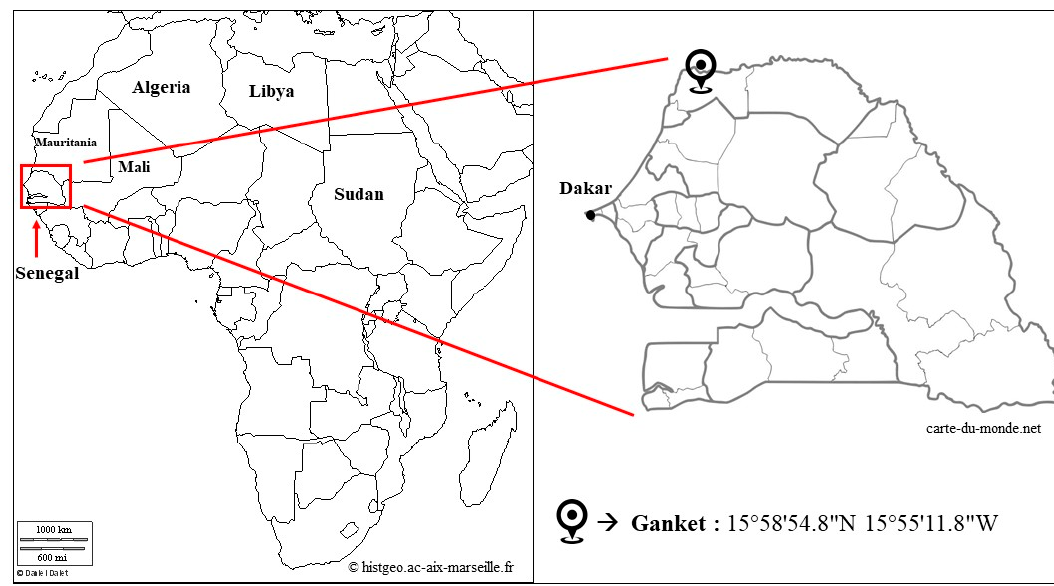
Figure 1. Site of sandy soil sampling in Ganket village, Senegal.